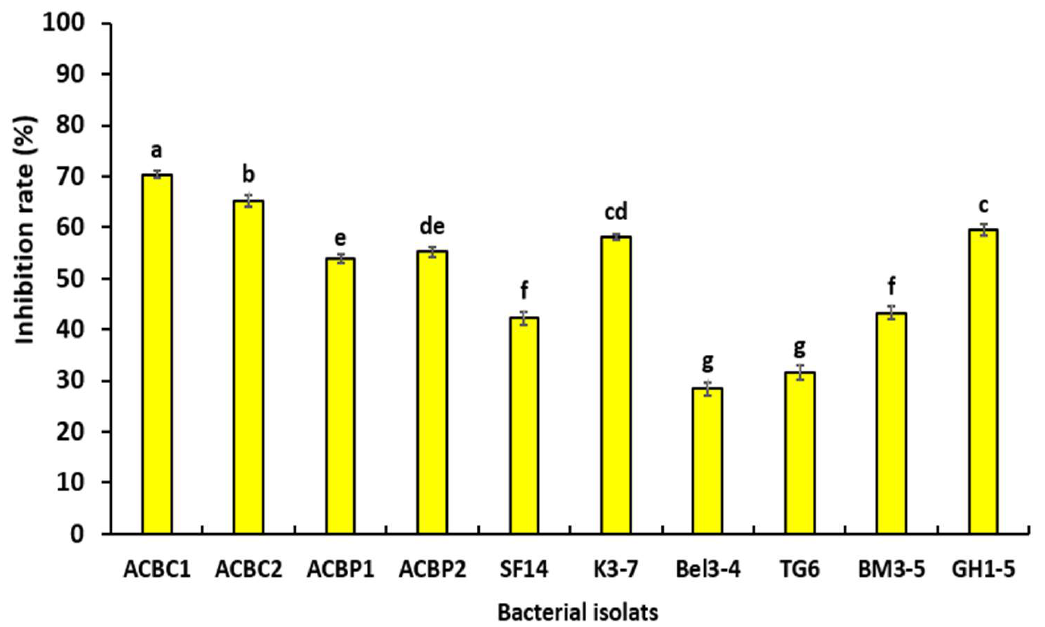
Figure 3. Effect of volatile organic compounds (VOCs), which were produced by tested bacteria on the inhibition of hyphal growth of P. schmitthenneri after 6 days of incubation at 25 ± 1 °C. Data in the figure are the average of two separate experiments with four replicates. According to the Tukey test, values with the same letter were not significantly different ( p ≤